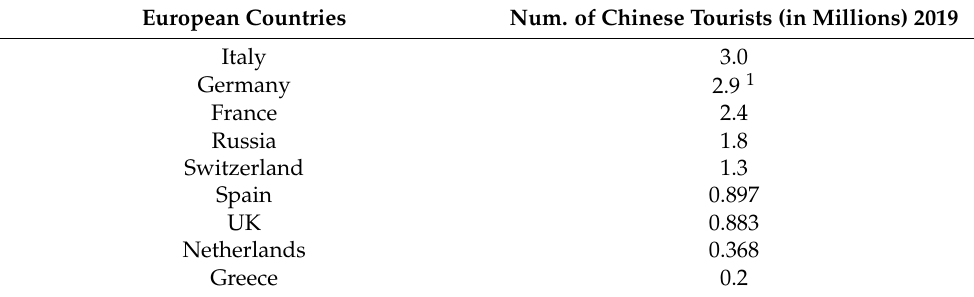
Table 1. Chinese tourist arrivals in European countries.